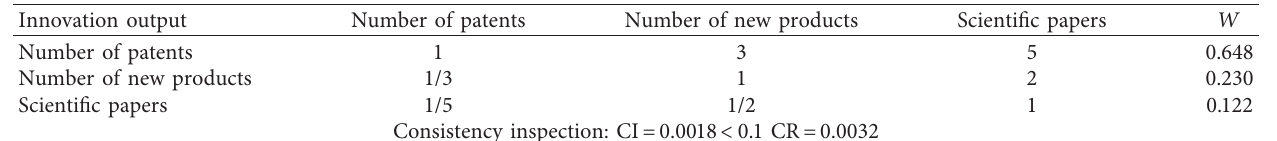
Table 6: Judgment matrix of innovation output.